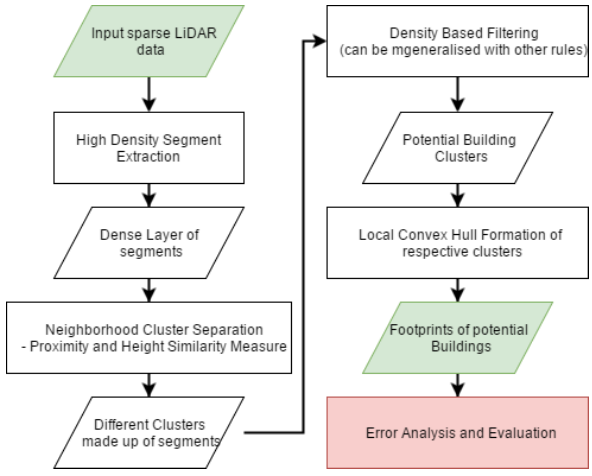
Figure 10. Footprint creation of the building